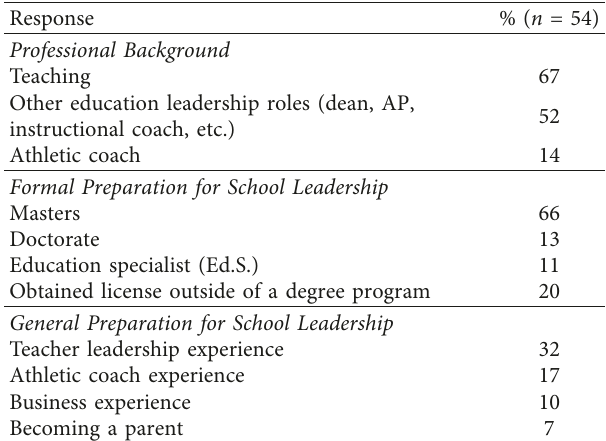
Table 1: Summary of educational background and school lead- ership preparation responses.